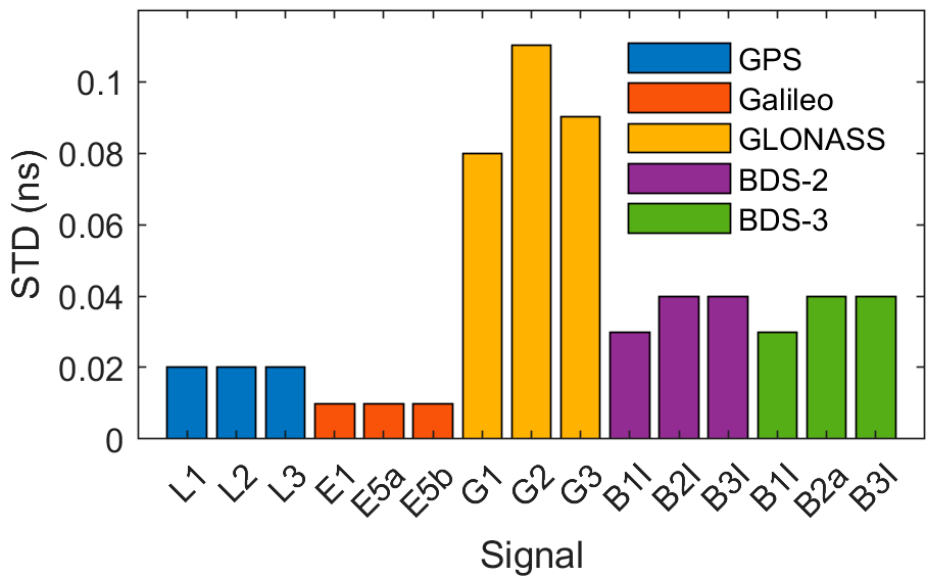
Figure 7. The multi-GNSS phase OSB series on DOY 290, 2021. A di ff erent color line represents a di ff erent satellite.